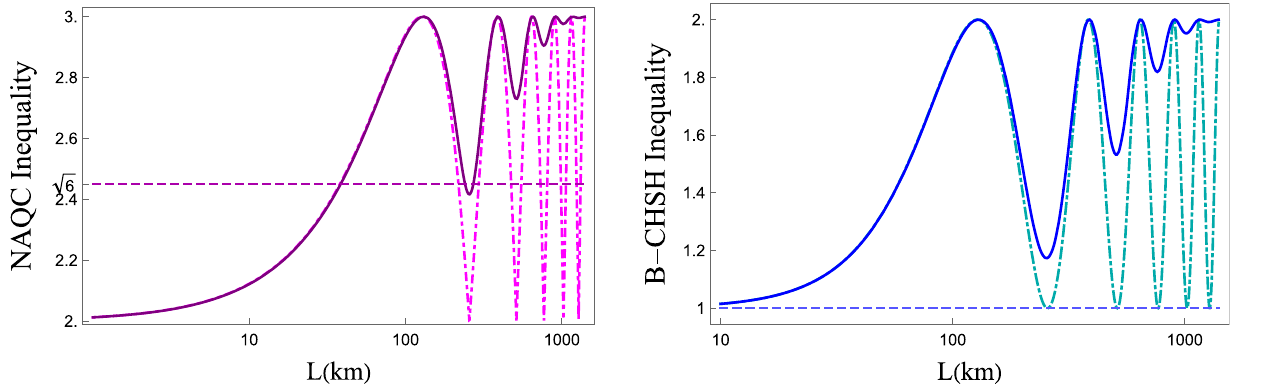
Fig. 5 NAQC and Bell-CHSH inequalities as a function of the dis- logarithmic scale. The darker magenta and the lighter blue dashed hor- tance. The plot is made using the data from MINOS experiment: izontal lines are the bounds of the NAQC and Bell-CHSH inequalities, = 2 . 32 + 0 . 12 × 10 − 3 eV 2 . The value sin 2 2 θ 23 = 0 . 95 + 0 . 035 − respectively. The solid and dot-dashed lines represent the plot for the and Δ m 2 − 0 . 08 32 0 . 036 wave packet approach and plane wave approximation, of the energy is E = 0 . 5GeV and σ x = 7 × 10 − 9 m . The L -axis is in